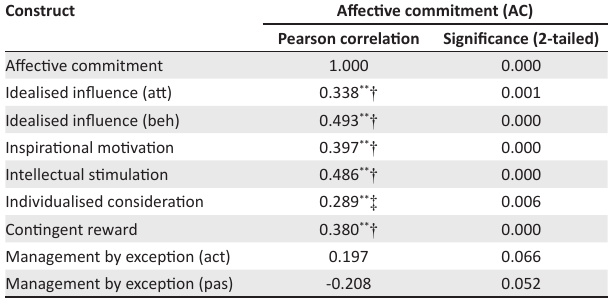
TABLE 3: Pearson product-moment correlation as regards organisational commitment and the multifactor leadership questionnaire dimension.